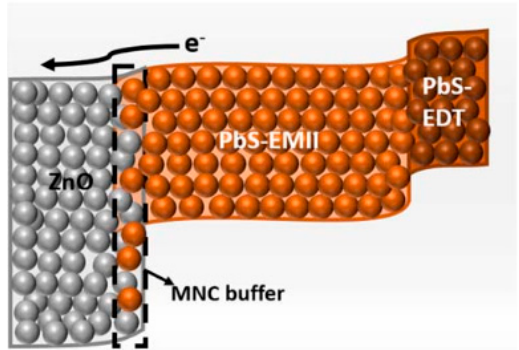
Figure 10. Scheme of energy band alignment of the solar cell with inserted mixed nanocrystal (MNC) layer between ZnO, PbS treated with 1-ethyl-3-methylimidazolium iodide (EMII) as an active layer and PbS-EDT electron blocking layer, in short-circuit condition. Reprinted with permission from [101]. Copyright (2017) American Chemical Society.